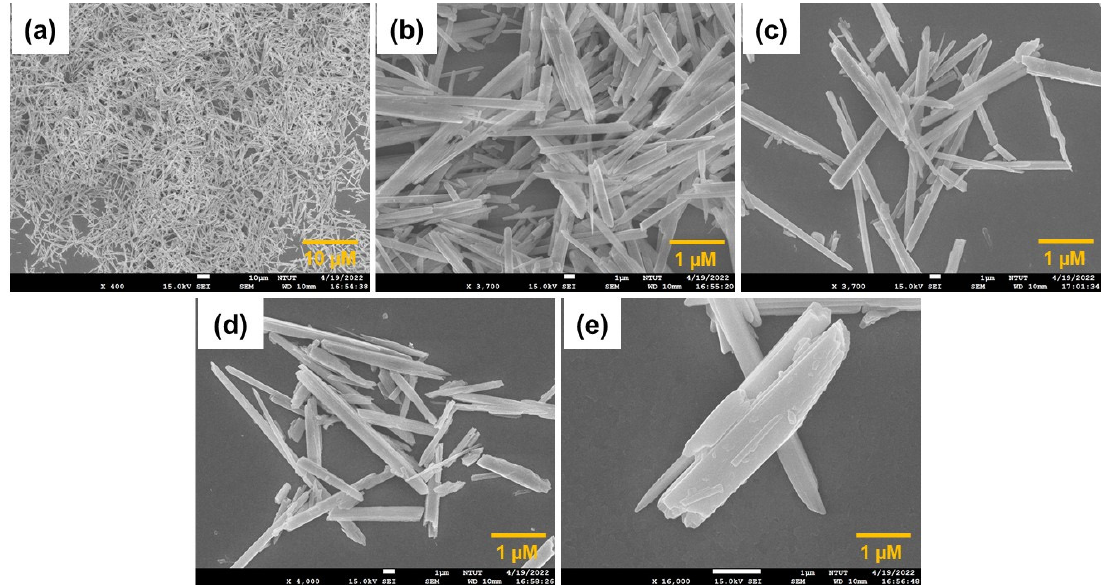
Figure 3. ( a – e ) High and low magnified FE-SEM images of NMO.